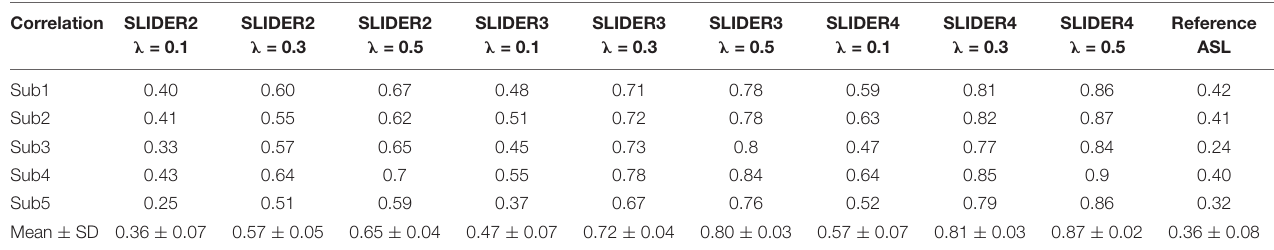
TABLE 2 | Slice blurring evaluation using autocorrelation of the reconstructed volume. Correlation SLIDER2